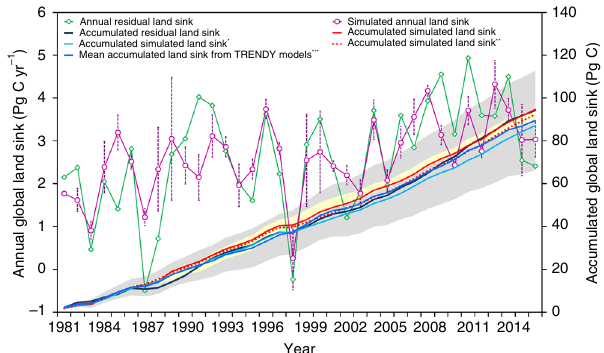
Fig. 2 Comparison of the simulated annual land sink (NEP) by BEPS and the residual land sink (RLS) estimated by the Global Carbon Project. The pink red error bars are the SDs of the annual land sink simulated using three different LAI datasets. The solid red line indicates the accumulated carbon sink simulated using three LAI datasets. For the accumulated simulated land sink* (light solid blue line), pixels with >20% areal changes in short vegetation or tree canopy are excluded in the accumulation. For the accumulated simulated land sink** (dashed red line), pixels with >30% changes are excluded. The solid dark line indicates the accumulated residual land sink estimated by the Global Carbon Project. The solid blue line is the mean of accumulated land sinks simulated by 15 TRENDY models, and the shaded gray area represents its uncertainty (mean ± SD). The shaded light yellow area represents the range of accumulated land sinks simulated using three different LAI datasets